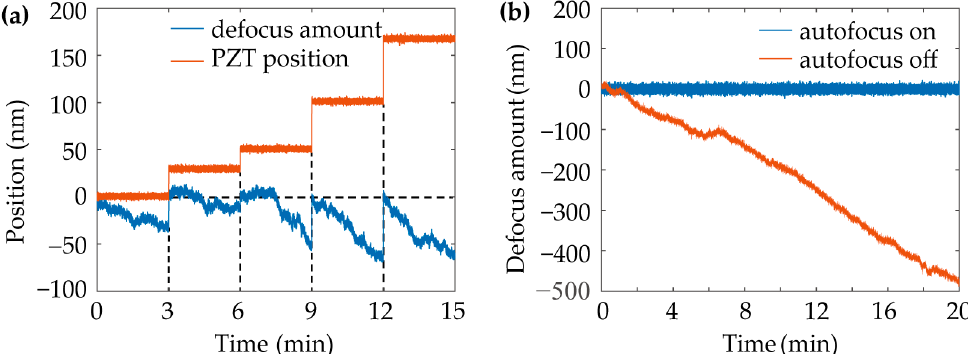
Figure 5. Defocus measurement and compensation experiments at a certain time. ( a ) The defocus was measured in 15 min and compensated every 3 min using PZT. ( b ) The defocus was measured in 20 min with the autofocus on and o ff .